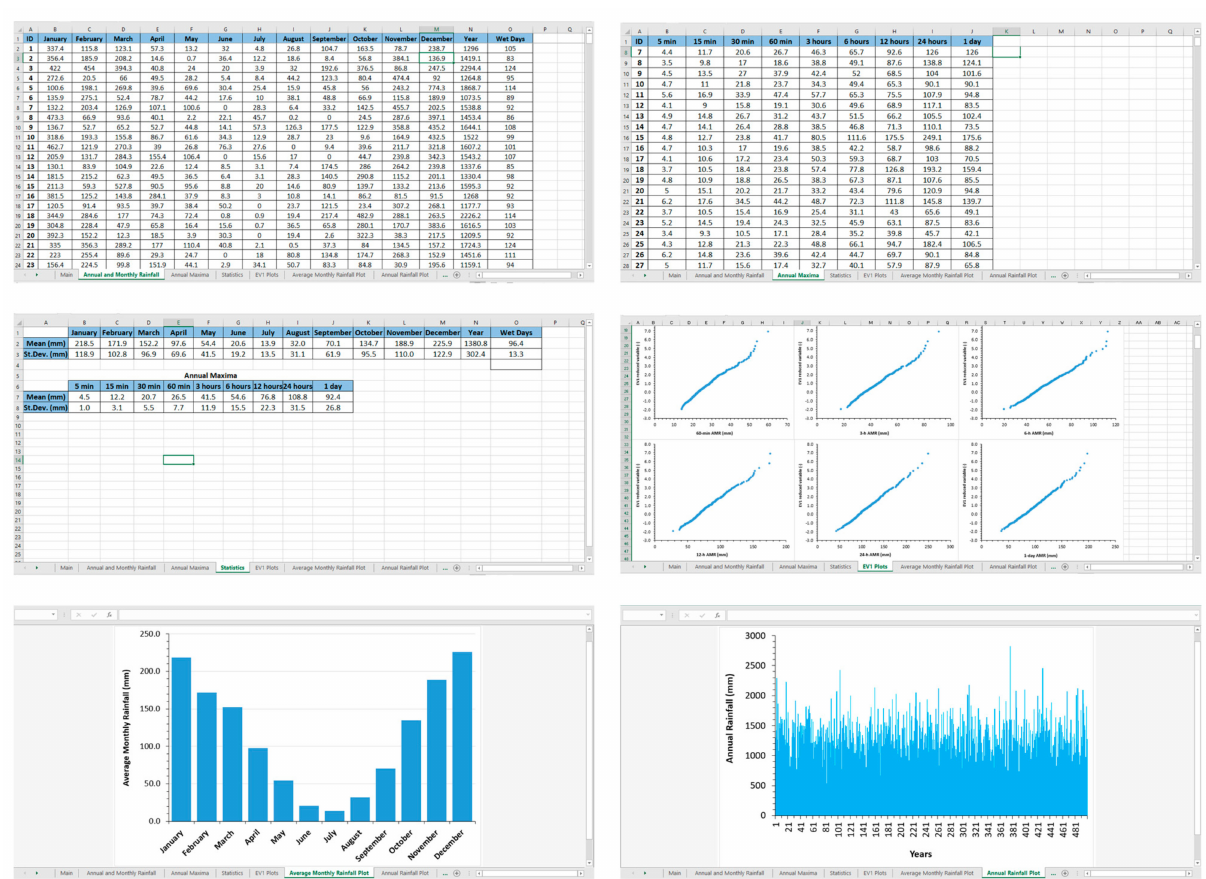
Figure 11. Examples of visualization in the different worksheets when the simulations are